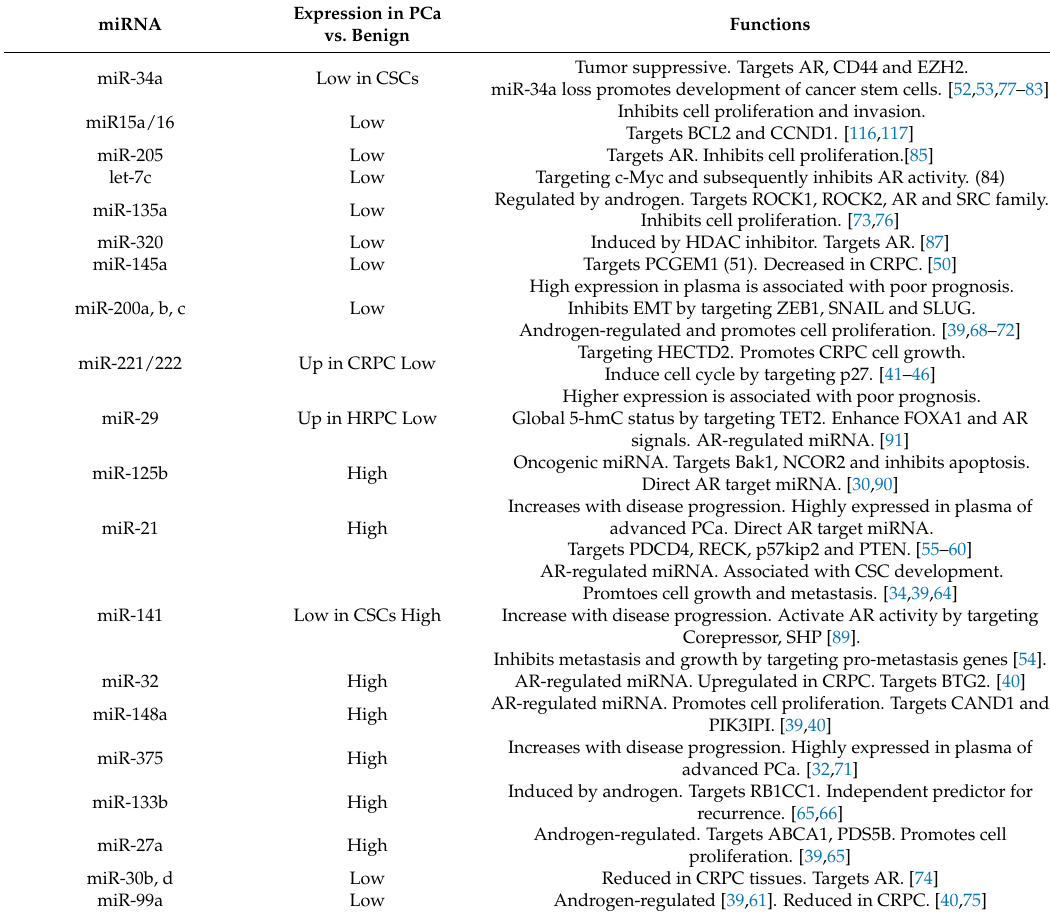
Summary of representative miRNAs reported to be important in the prostate cancer